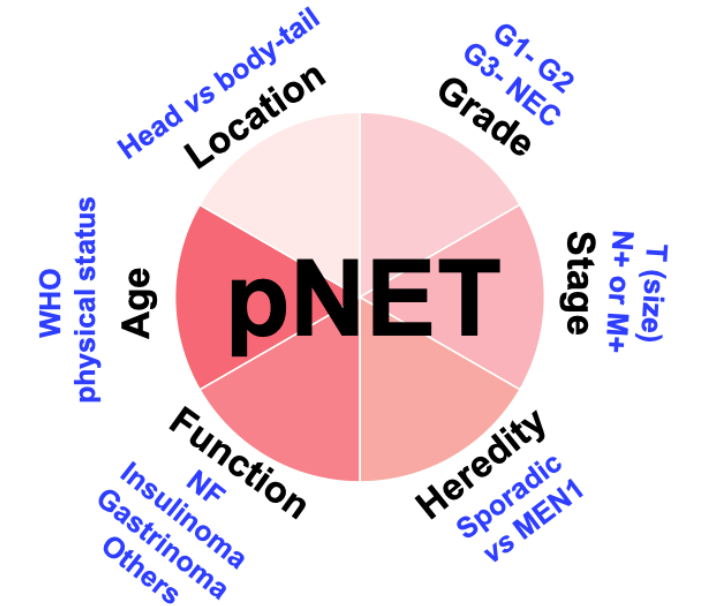
Figure 1. Description of the various factors that should be considered planning the surgical management of patients with